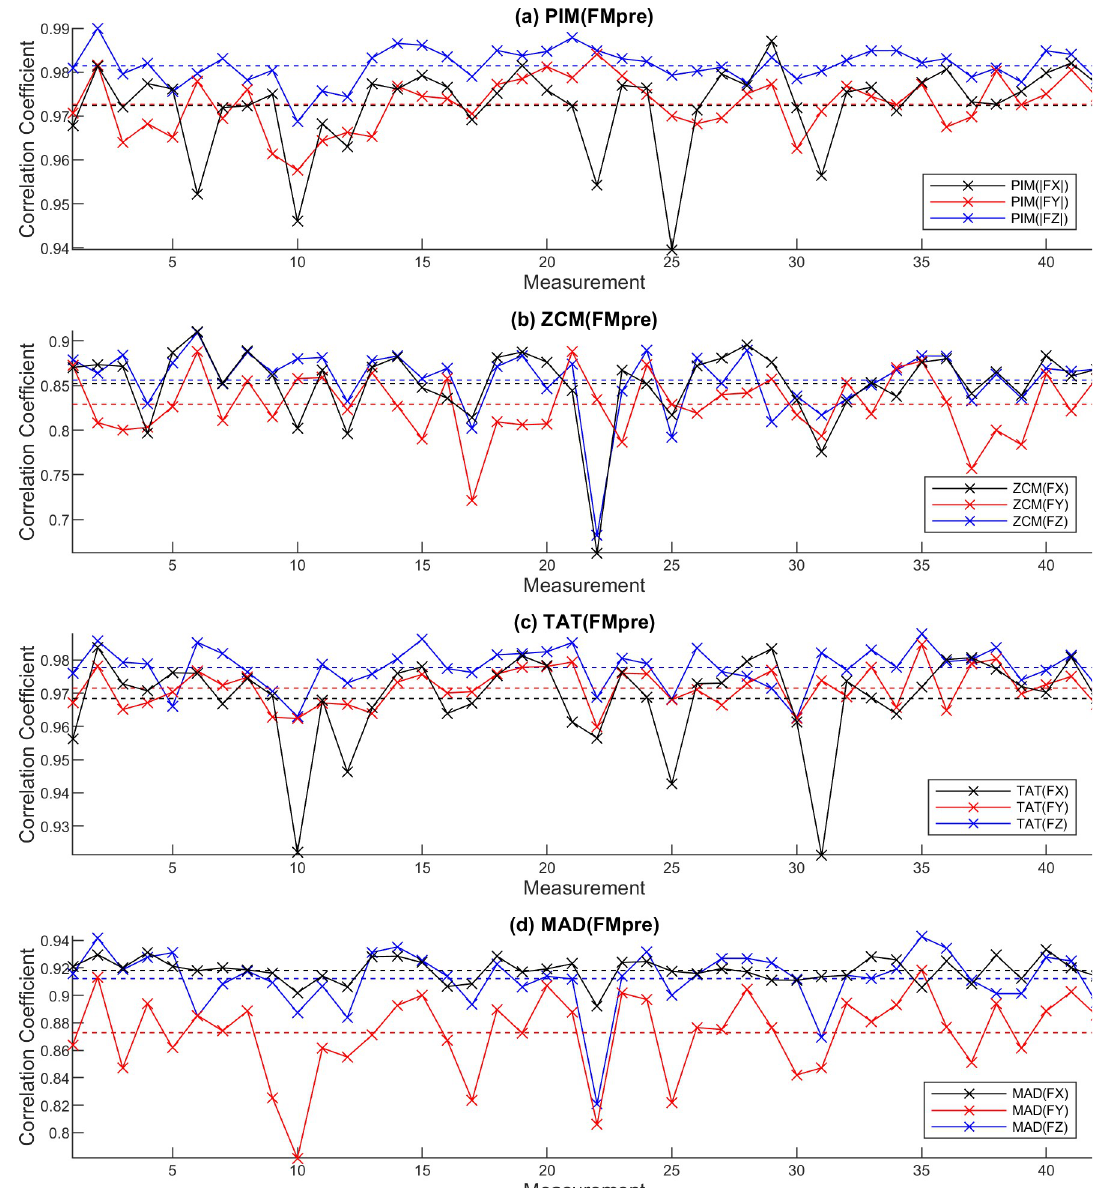
Fig 9. Correlation between filtered axial accelerations (FX, FY, FZ) to the vector magnitude calculated from them (FMpre) in the case of 42 measurements regarding the PIM (a), ZCM (b), TAT (c) and MAD (d) activity metrics. The means of the individual correlation curves are also represented as dotted horizontal lines with matching